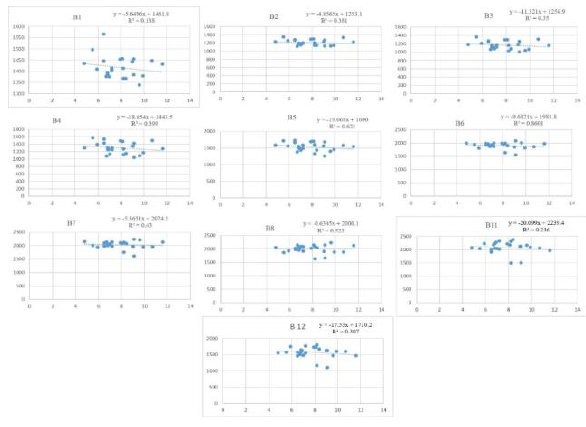
Figure 3. diagram of the coefficient of determination of Sentinel-2 sensor